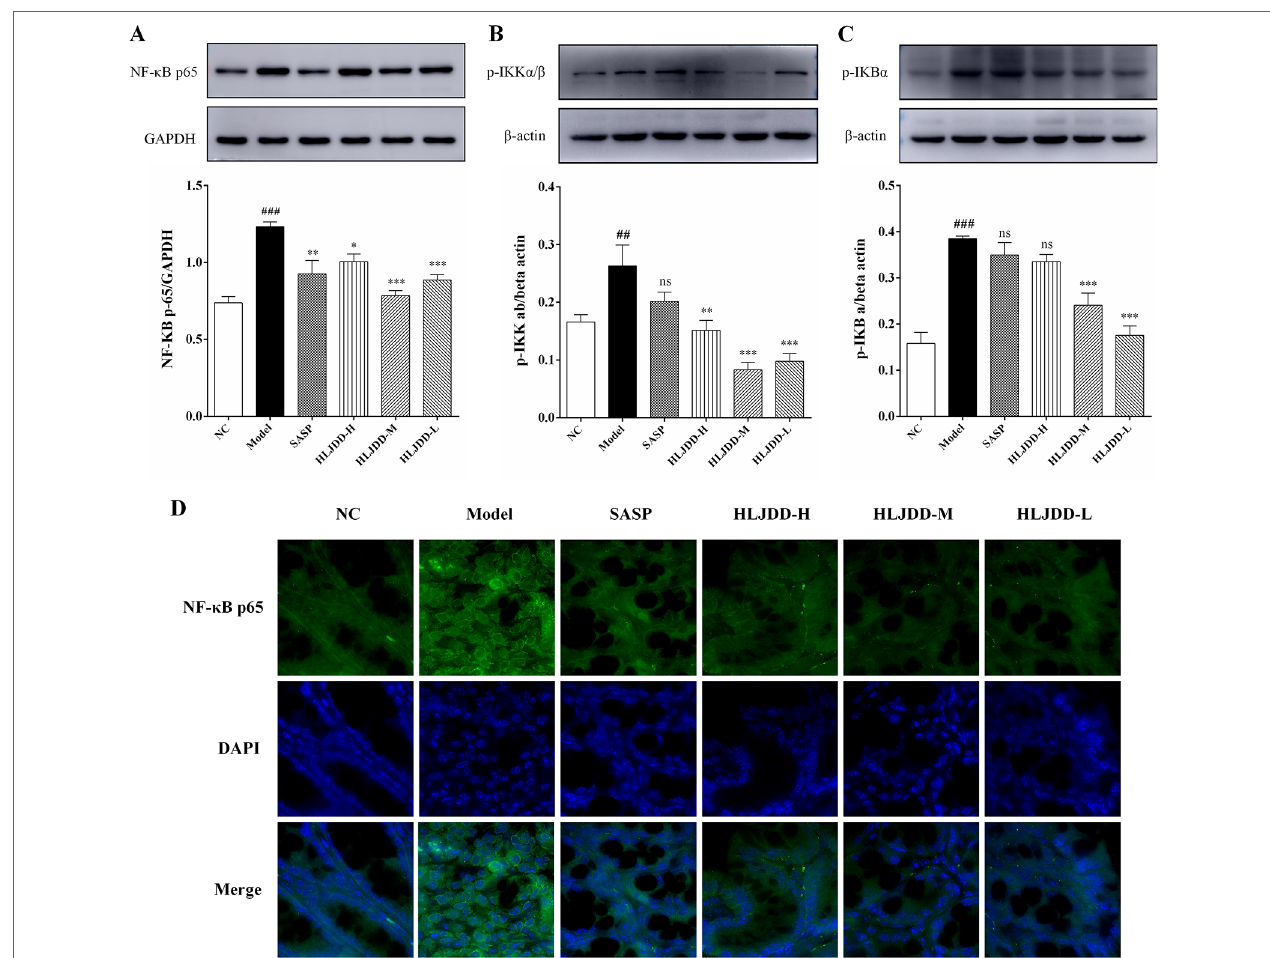
FIgURE 7 | Inhibitory effect of HLJDD on NF-κB signaling pathway in UC mice. Western blot analysis of protein expression levels of NF-κB p65 (A) , p-IκKα/β (B) , and p-IκBα (C) in colon tissue. (D) Immunofluorescence analysis of NF-κB p65 (green) in colon mucosa (600 × magnification). DAPI was used for nuclear staining (blue). Data are expressed as the mean ± SD, n = 5 per group. ## p < 0.01, ### p < 0.001 vs. NC group; * p < 0.05, ** p < 0.01, *** p < 0.001 vs. model group. ns, no significant. (For interpretation of the references to color in this figure legend, the reader is referred to the web version of this